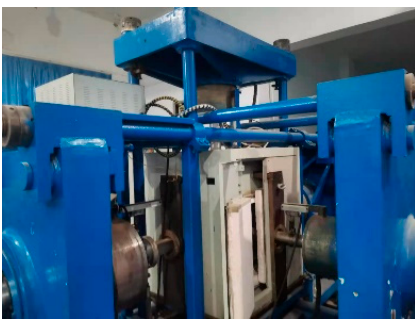
Figure 3. Dynamic loading system.